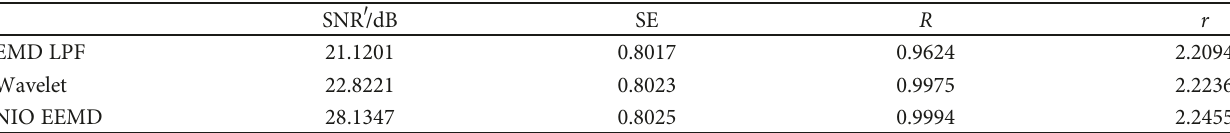
Table 3: Denoising indexes of the three